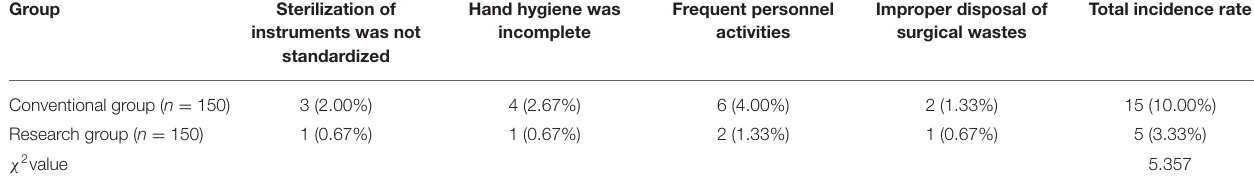
TABLE 5 | Occurrence of irregular events in the two groups ( n , %).